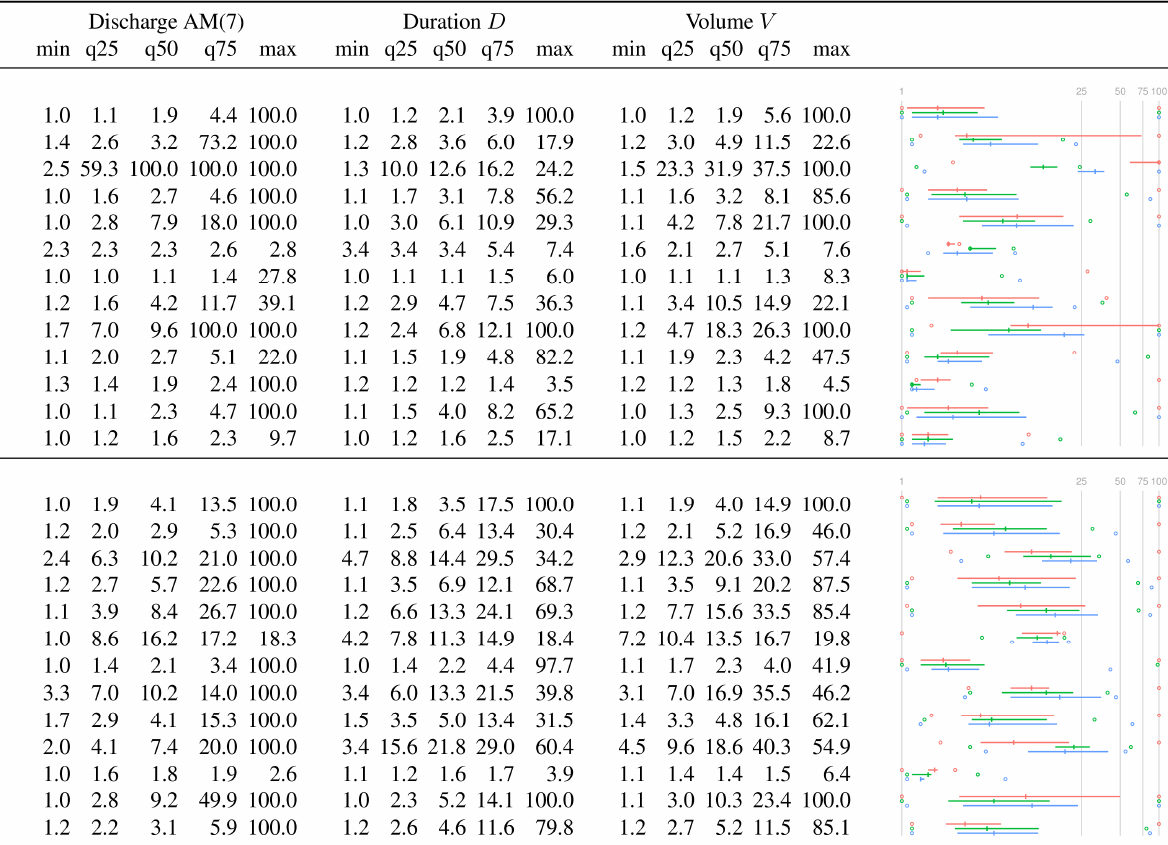
Table A1. Statistical summary of low flow and streamflow drought characteristics of the event of 2015 (top) and 2003 (bottom) by country. The terms min, q25, q50, q75, and max refer to sample quartiles of return periods (with non-exceedance probabilities of 0, 0.25, 0.50, 0.75, and 1). These statistics are also displayed in the box plots (right panels, where red color refers to low flow discharge AM(7), green: